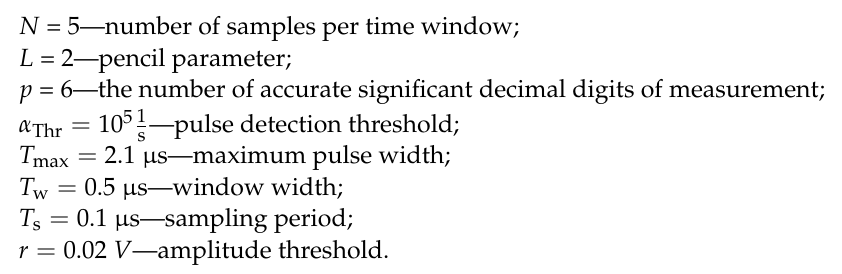
Table 3 shows the standard deviations of the temporal error of the pulse. Table 3. Standard deviation of temporal error. Unit: µ s. K3E—three-phase-to-ground